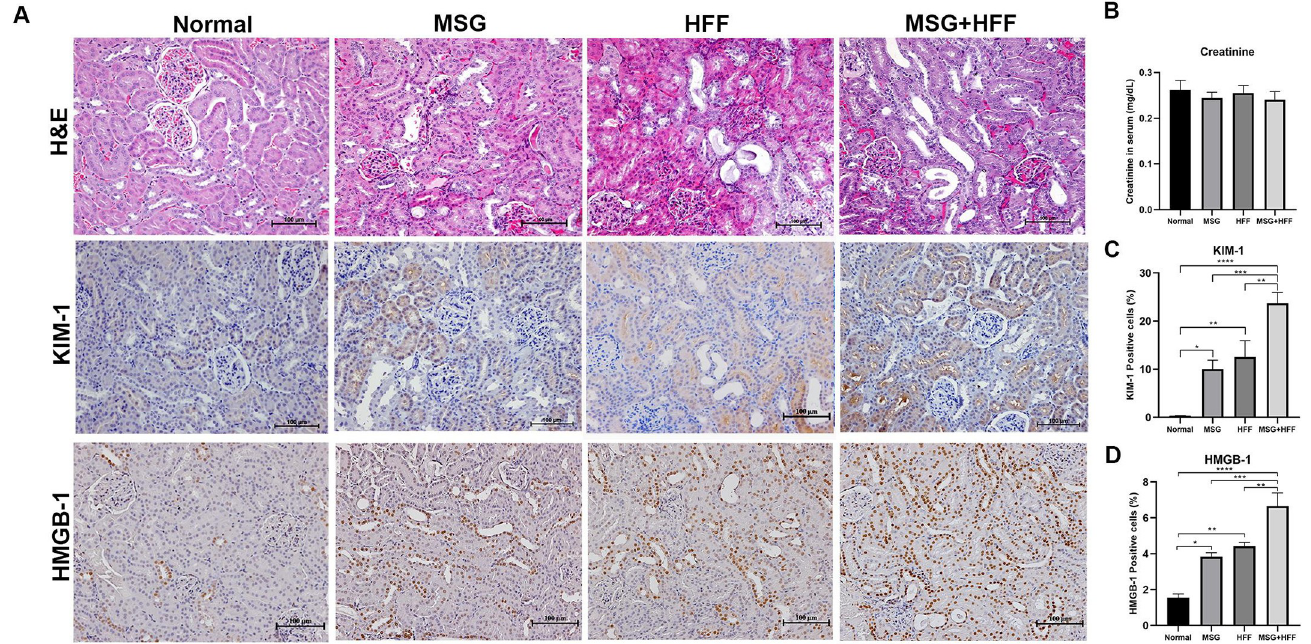
Fig 1. (A) Representative photographs of sections of hamster kidneys stained by H&E and for expression of kidney injury molecule-1 (KIM-1) and high-mobility group box 1 protein (HMGB1), (B) serum creatinine levels and percentages of (C) KIM-1- and (D) HMGB1-positive cells. The extent of injury in these kidneys was evaluated after 8 months on experimental diets including the normal group (n = 6), monosodium glutamate-treated group (MSG, n = 6), high-fat and high- fructose diet-treated group (HFF, n = 6) and the MSG and HFF diet-treated group (MSG+HFF, n = 6). Findings are presented as mean ± SEM. � , �� , ��� are p < 0.05, p < 0.01 and p < 0.0001, respectively, compared with normal control or MSG or HFF.